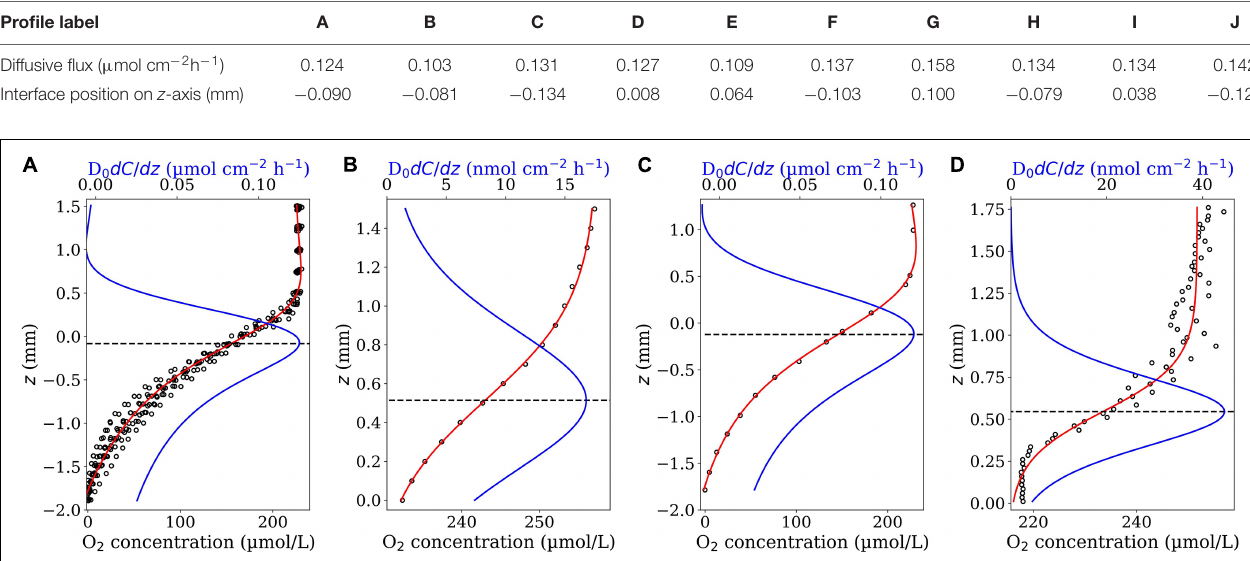
TABLE 1 | Fluxes and interface positions in the considered sediment ( Figure 5 ) obtained by using the Derivative-Max model.